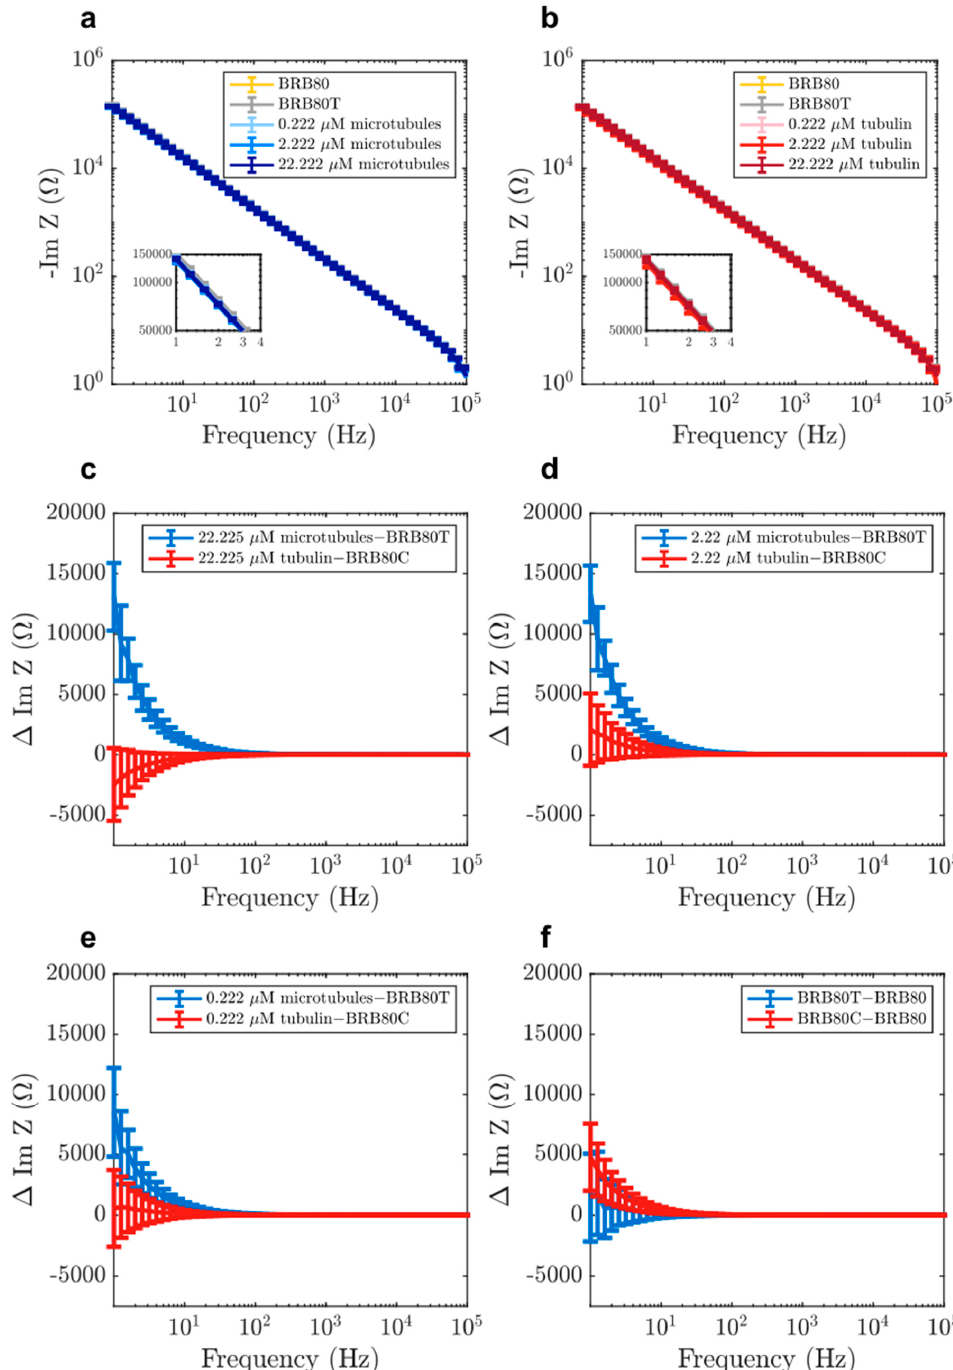
Figure 3. Examples of raw values of imaginary component of impedance in solutions containing ( a ) MTs and ( b ) tubulin, for the purpose of displaying typical impedance values. Mean di ff erences in the imaginary component of impedance as a function of input AC (alternating current) frequency at total tubulin concentrations of ( c ) 22.225 µ M (n = 22 experiments for tubulin, n = 21 for MTs), ( d ) 2.222 µ M (n = 35 experiments for tubulin, n = 49 for MTs) ( e ) 0.222 µ M (n = 35 experiments for tubulin, n = 49 for MTs), ( f ) comparison of the e ff ects of paclitaxel (BRB80T) and colchicine (BRB80C, n = 49 experiments for BRB80T, n = 35 for BRB80C, n = 84 experiments for BRB80). Error-bars represent standard